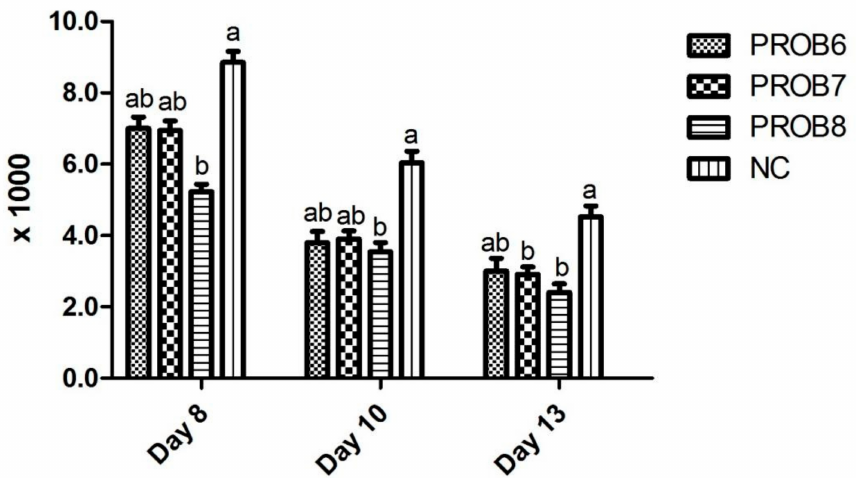
Figure 2. Oocysts per gram (OPG) of feces with experimentally induced coccidiosis in various treatment groups at day 8, 10, and 13 post infection. Means with different superscripts (a, b) are significantly different ( p < 0.05). X-axis represents the numbers of different groups, and y-axis shows the numbers of oocyst in the chicken dropping. PROB6 = L. plantarum (1 × 10 6 CFU) supplemented group in feed; PROB7 = L. plantarum (1 × 10 7 CFU) supplemented group in feed; PROB8 = L. plantarum (1 × 10 8 CFU) supplemented group in feed; NC = infected, non-medicated treatment group; Cont = non-infected, non-medicated group.